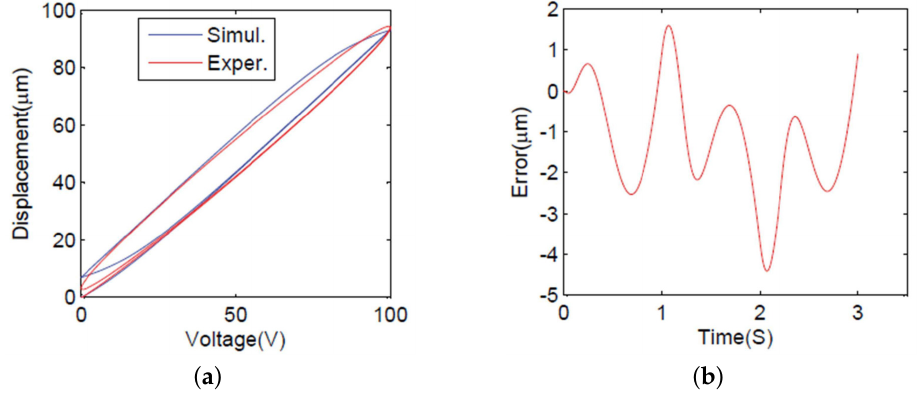
Figure 3. Hysteresis. ( a ) The experimental hysteresis loop and the simulation hysteresis loop. ( b ) Errors.